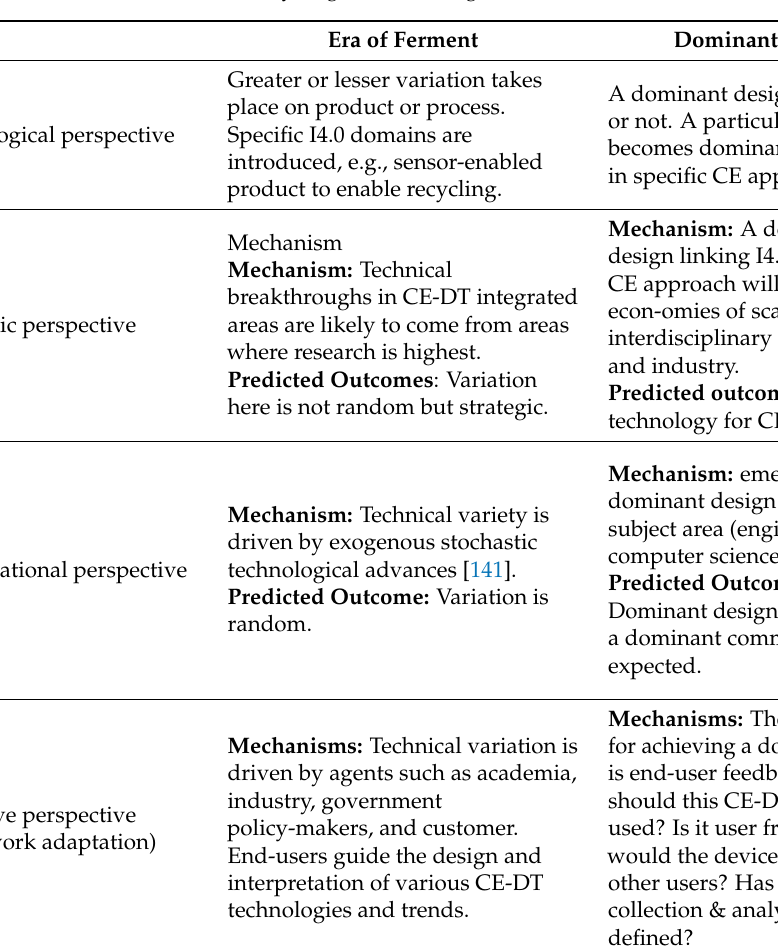
Table 6. Synergistic and integrative CE-DT framework through TLC (As adapted from Kaplan & Tripsas, 2008;